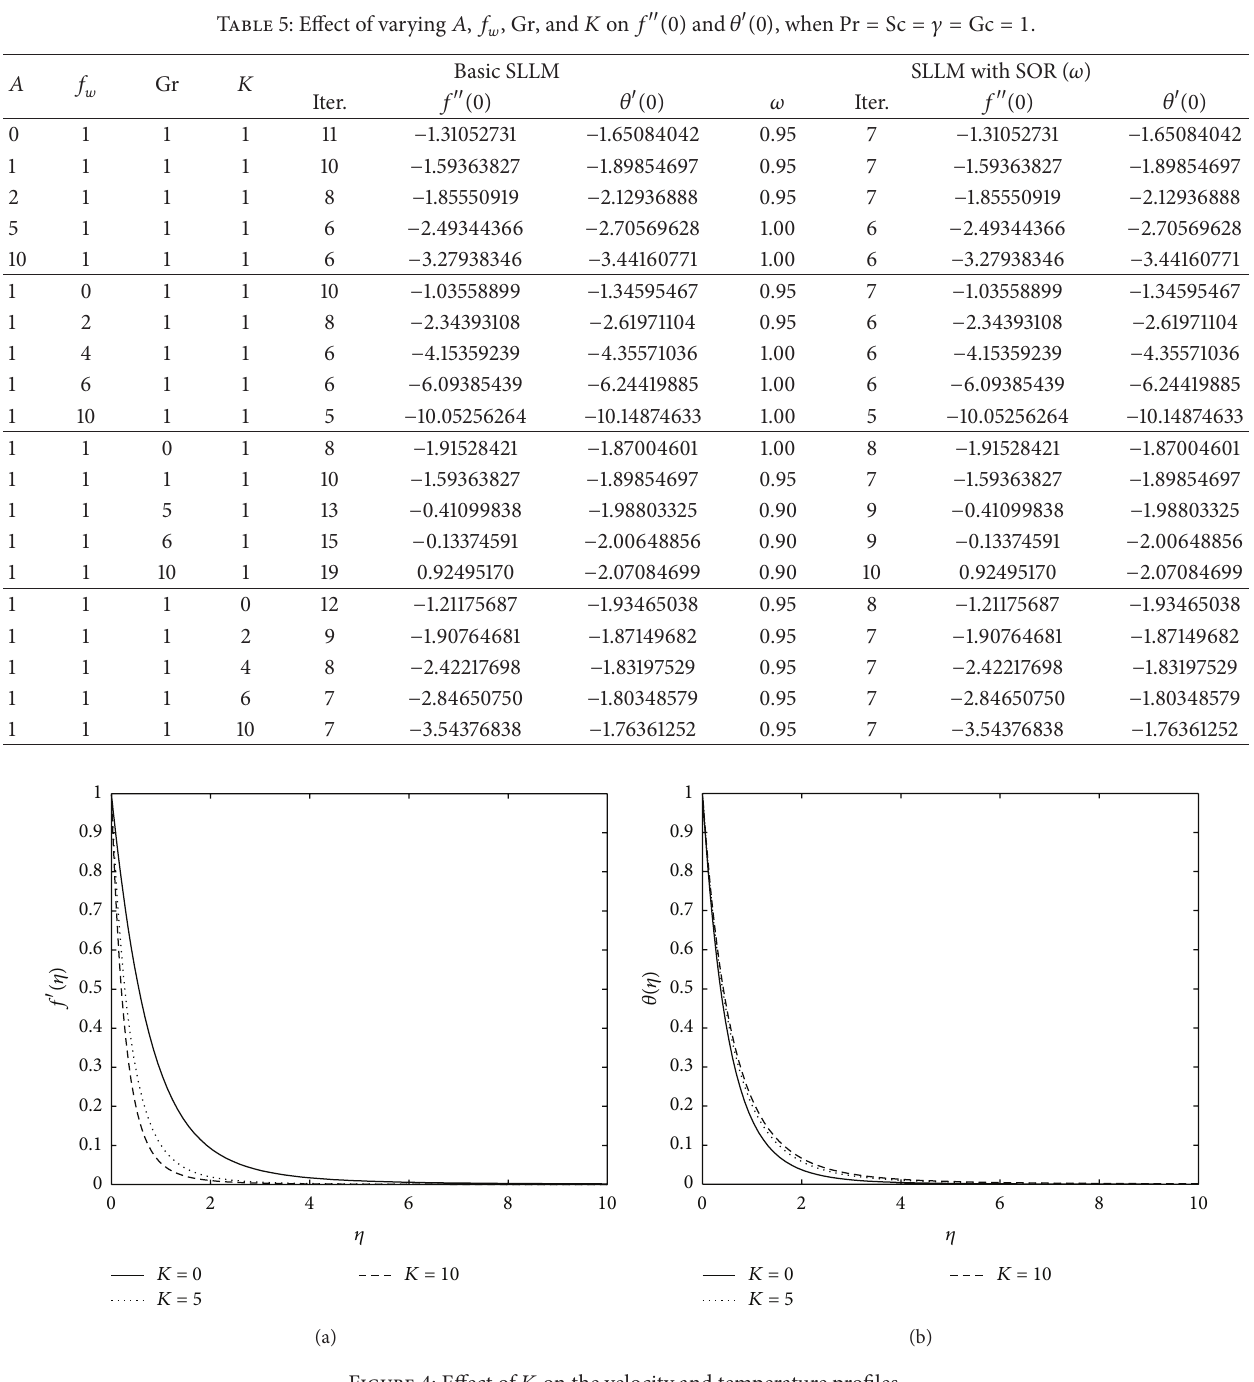
Figure 4: Effect of 𝐾 on the velocity and temperature